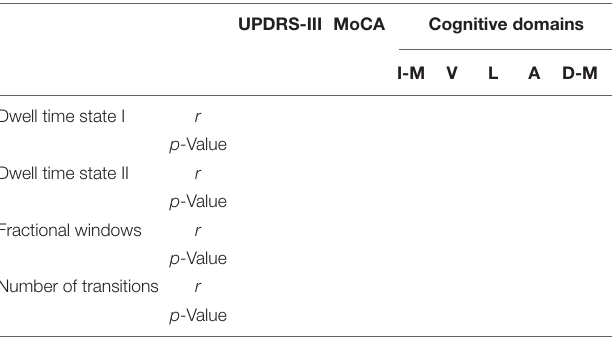
TABLE 2 | Correlation between dynamic functional connectivity temporal properties and clinical characteristics (before intervention, after intervention, and